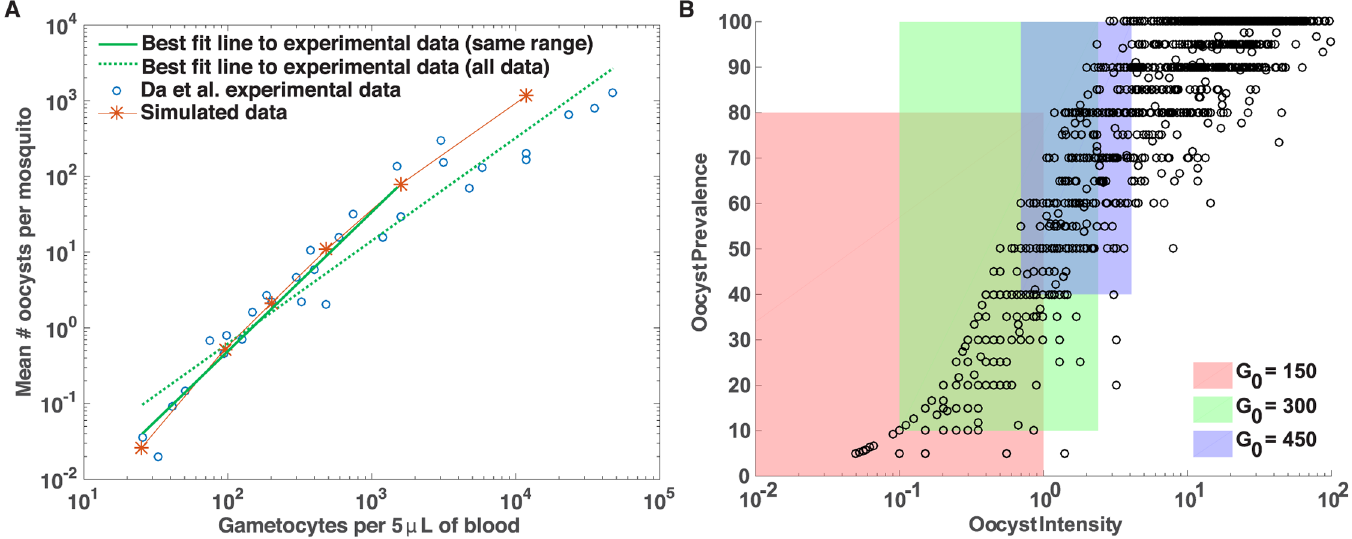
Fig 2. Comparison of life cycle model with published data. (A) Experimental data (blue circles) extracted (usingPlot Digitizer) from Figure 1A in [46] along with the mean numberof oocysts per mosquitocalculatedfrom our simulationdata. The experimental data is scaled to be in units of gametocytesper five μ L rather than gametocytes per one μ L. A regressionline to the log-logexperimental data (dashedgreen) and to a subset of the experimental data over the range of initial gametocyte densitiesused to parameterize the model (solid green) is shown along with our model simulations (red stars). (B) Experimental data (black circles) from Figure 1 in [47] of oocyst intensity and prevalence(reproduced with permission) comparedto results of the simulationstarting from 150 (red shading),300 (green shading) and 450 (blue shading) gametocytes. The colored areas represent the range of oocyst intensity and prevalenceobserved from